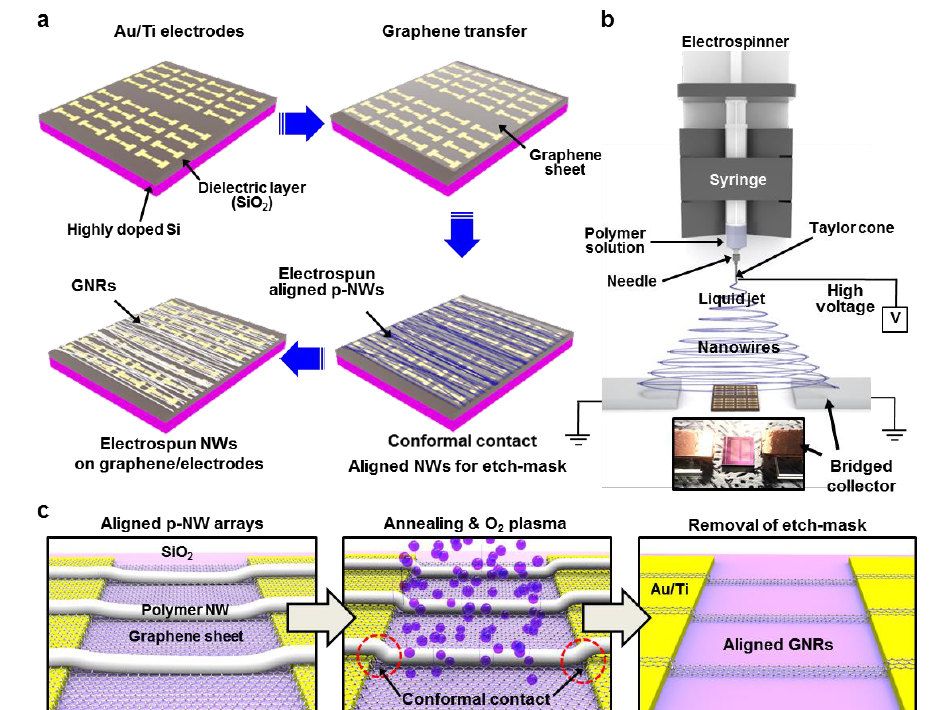
Figure 1. Schematic diagram of electrospinning-based graphene nanoribbons (GNR) fabrication and integration into a field-effect transistor (FET). ( a ) The electric pad preparation, graphene transfer, etch-mask formation, and the arrays of the GNR-based FETs (clockwise). ( b ) A schematic of the electrospinning set up to transfer the highly aligned arrays of p-NWs with the help of a bridged collector; the inset shows a real photograph of the process. ( c ) Annealing process for the conformal contact of the p-NW underlying the graphene sheet/electric pads to enhance the step-coverage, followed by O 2 plasma etching and the removal of the p-NW with an organic solvent.